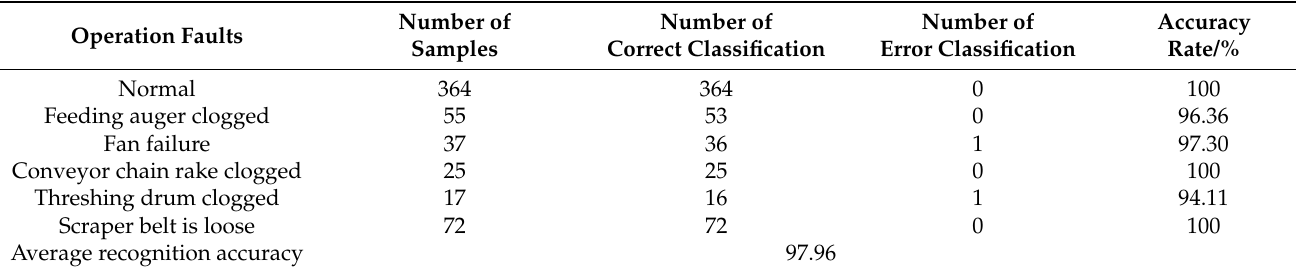
Table 4. The fault identification results of the IPSO-SVM model on the test set data.